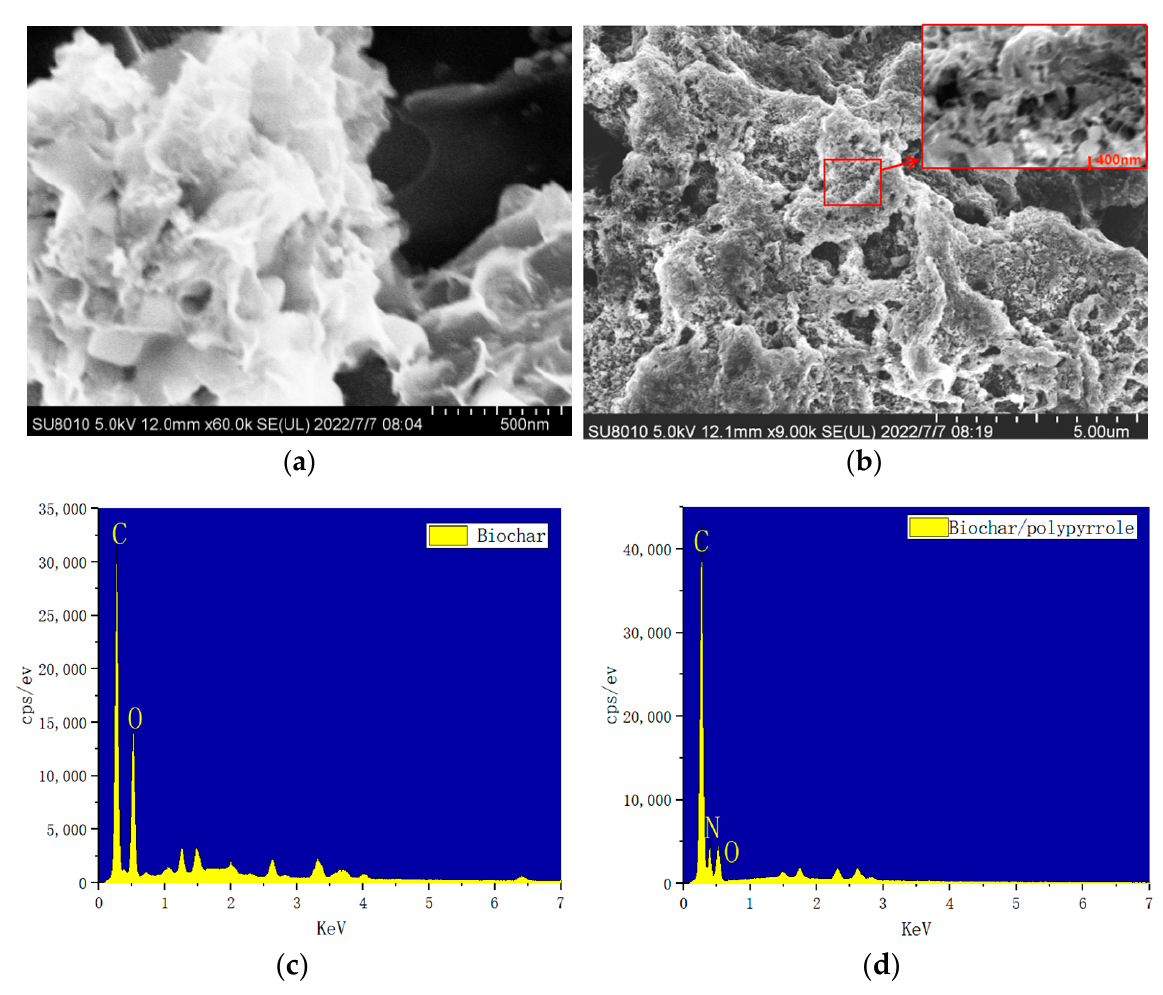
Figure 3. BET spectrum of ( a ) biochar and ( b ) biochar/polypyrrole.